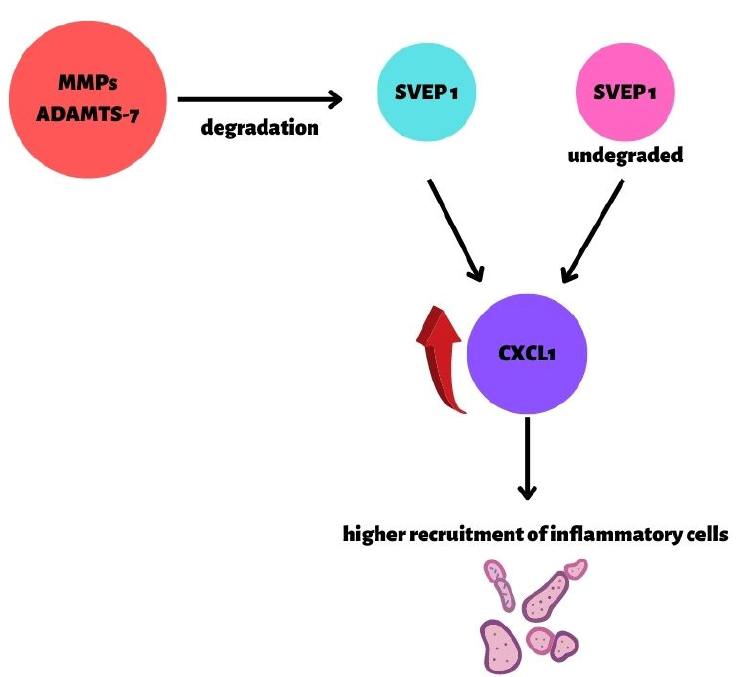
Figure 2. The role of SVEP1 in atherosclerosis and CAD [56]. CXCL1 expression is dependent on the presence of SVEP1 . Only in the presence of SVEP1 is the CXCL1 expression silenced. Two factors have a significant influence on the expression of CXCL1 : MMPs and ADAMTS- 7 (specific metallopro- teinases), which can reduce the wildtype SVEP1 ; mutant SVEP1 ( SVEP1_p.D2702G missense variant). Consequently, the secretion and recruitment of inflammatory cells are